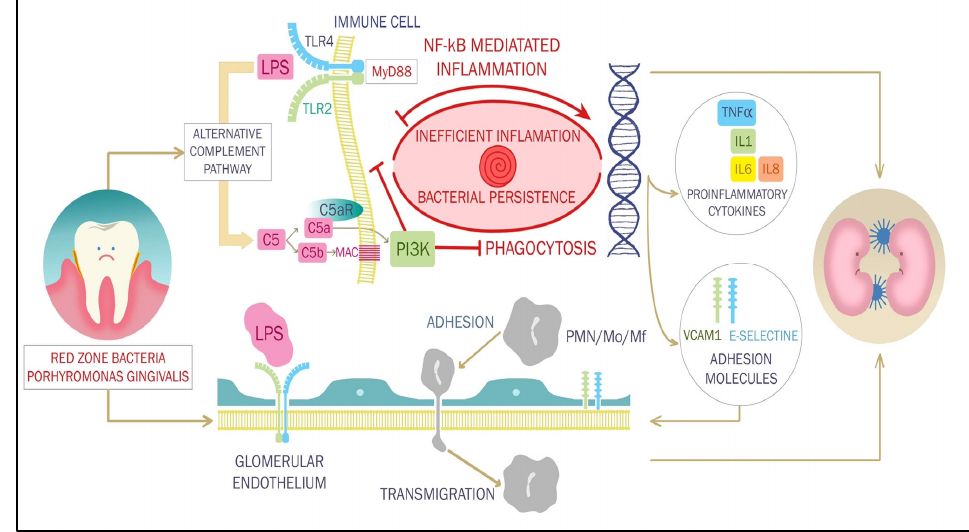
Figure 1. Toll-like receptor (TLR)2 and 4 mediated activation of innate immunity triggered by bacterial lipopolysaccharide of Porphyromonas gingivalis and other red zone bacteria leads to immune cell recruitment and activation both in periodontal tissues and the kidney. Nuclear factor k B (NF-kB)-mediated expression of proinflammatory cytokines like interleukin (IL)1 and 6, tumor necrosis factor (TNF) α , and adhesion molecules such as vascular cell adhesion molecule 1 (VCAM1) and E-selectins mediate polynuclear adhesion and transmigration in in various tissues, including the kidney. However, alternative intracellular cascades to the classical myeloid differentiation primary response gene 88 (MyD88) dependent pathway, phosphatidyl inositol 3 kinase (PI3K), or complement factor 5 (C5), cyclic AMP (cAMP), and protein-kinase-mediated membrane attack complex (MAC) activation-block normal phagolysosome activation of macrophages and neutrophils, leading to inefficient, protracted periodontal inflammation.